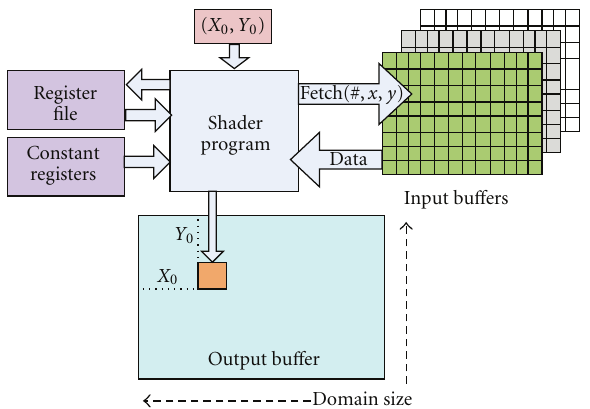
Figure 1: The interaction of a shader program with memories and